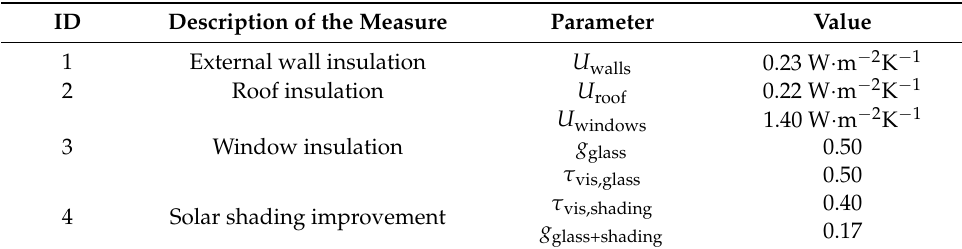
Table 3. Properties of the energy efficiency measures for the building envelope.